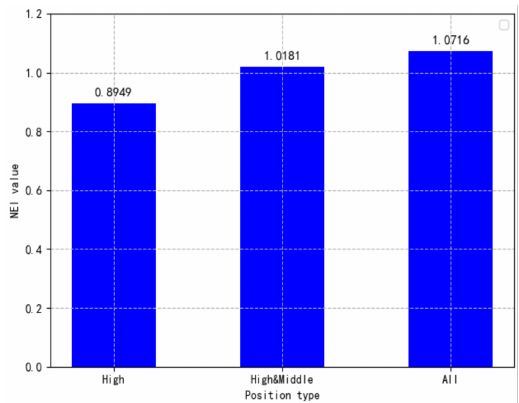
Figure 14. Navigation efficiency index (NEI) versus position